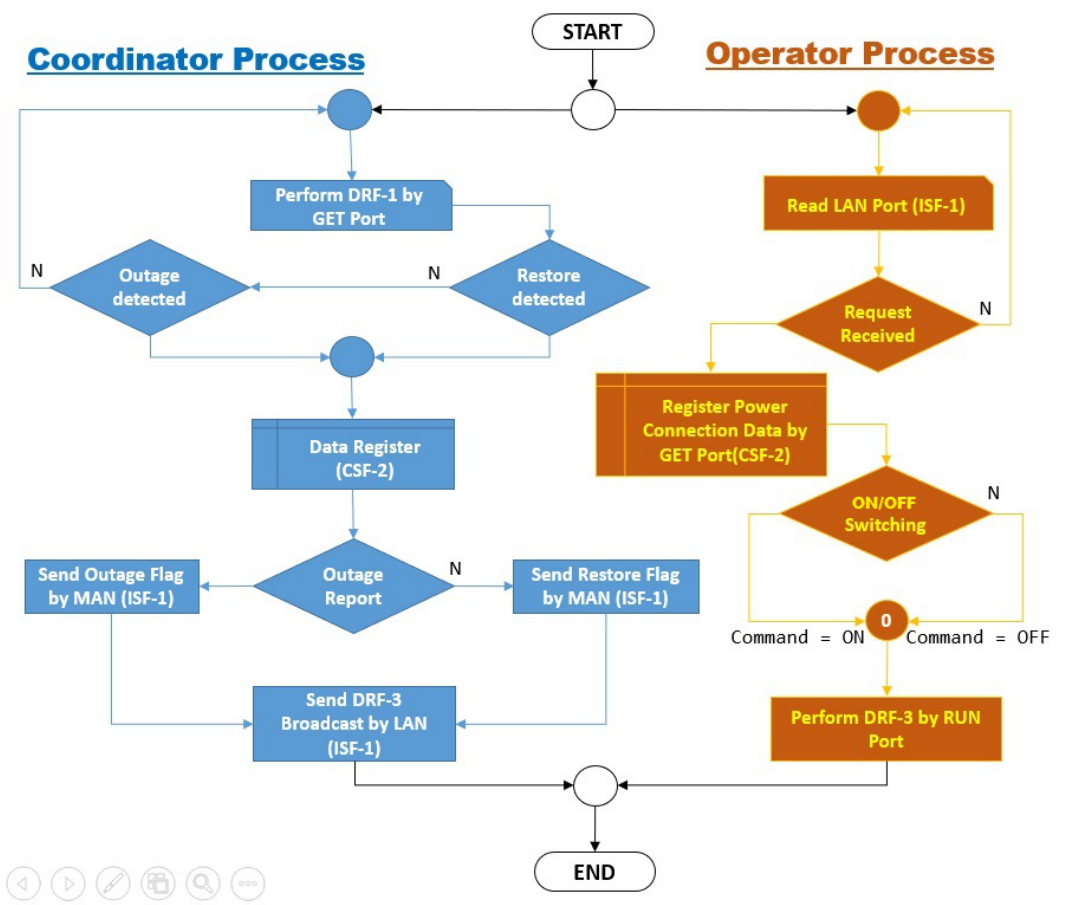
Figure 15. Flow diagram describing the test algorithm for Outage/Restore Detection